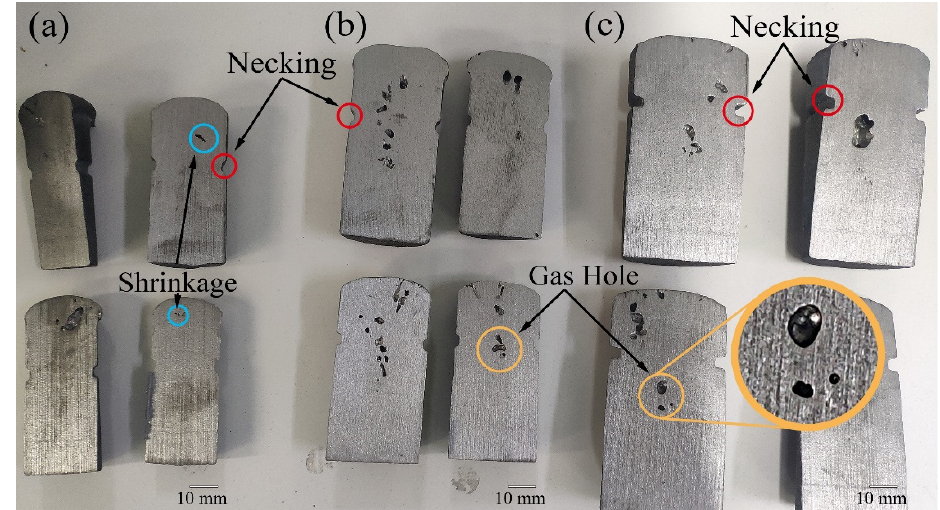
Figure 2. Pouring results of three different sizes of cylindrical necking test samples: ( a ) Ø26 × 55 mm, ( b ) Ø30 × 60 mm, and ( c ) Ø40 × 70 mm.